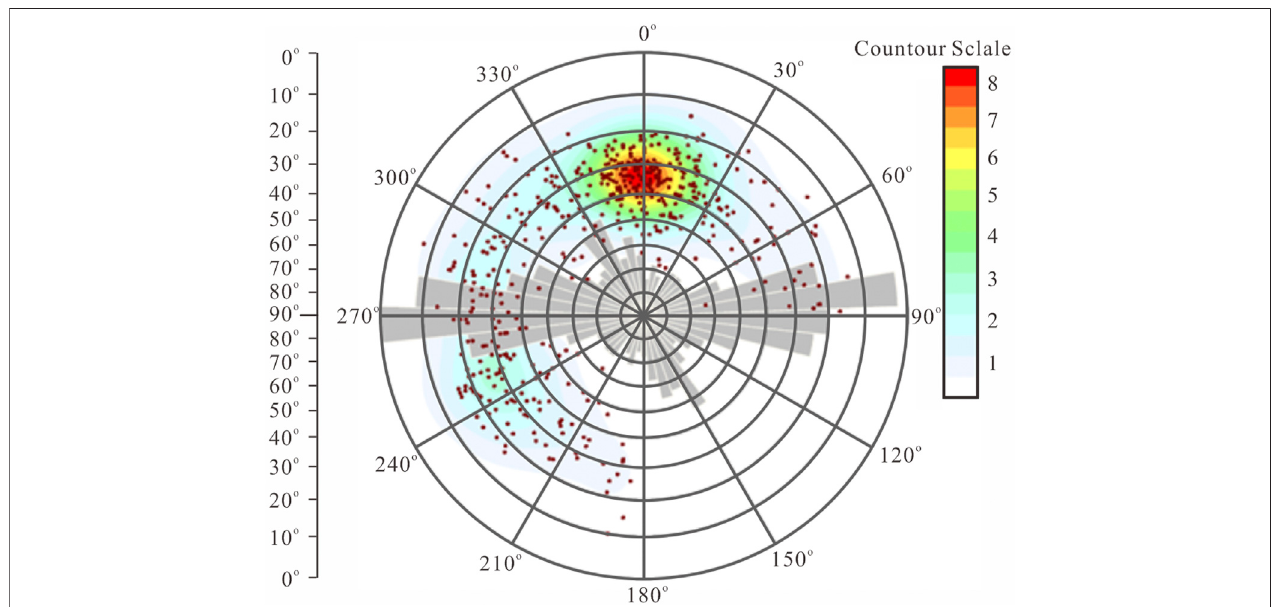
FIGURE 4 | Well logging fracture rose diagram and Fisher fractal statistical results for well D22 (the rose diagram represents the fracture trend, and the scattered points are the projection of the trend and the plunge of each fracture).